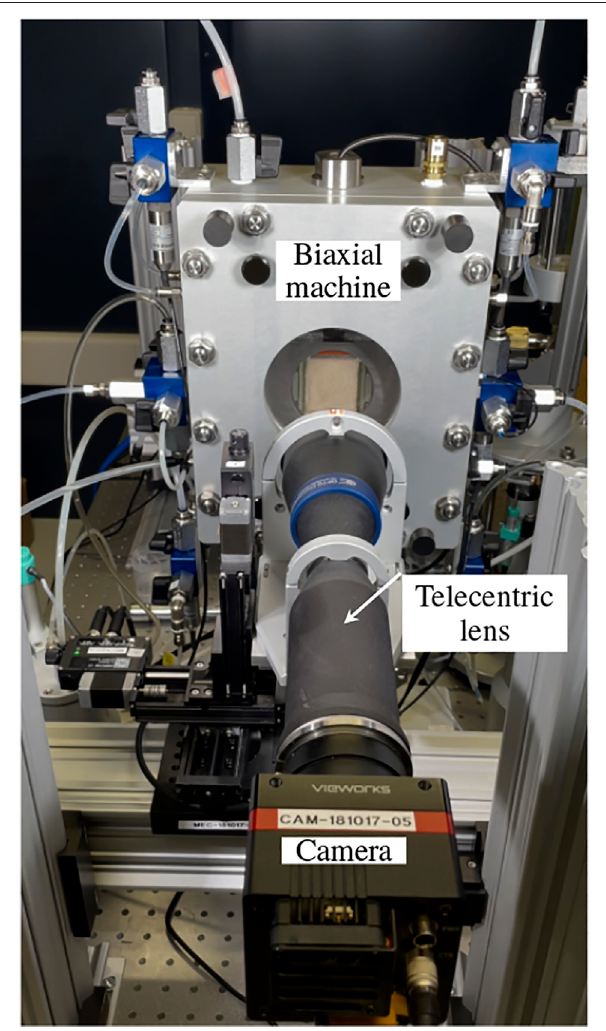
FIGURE 1 | Biaxial machine endowed with its optical